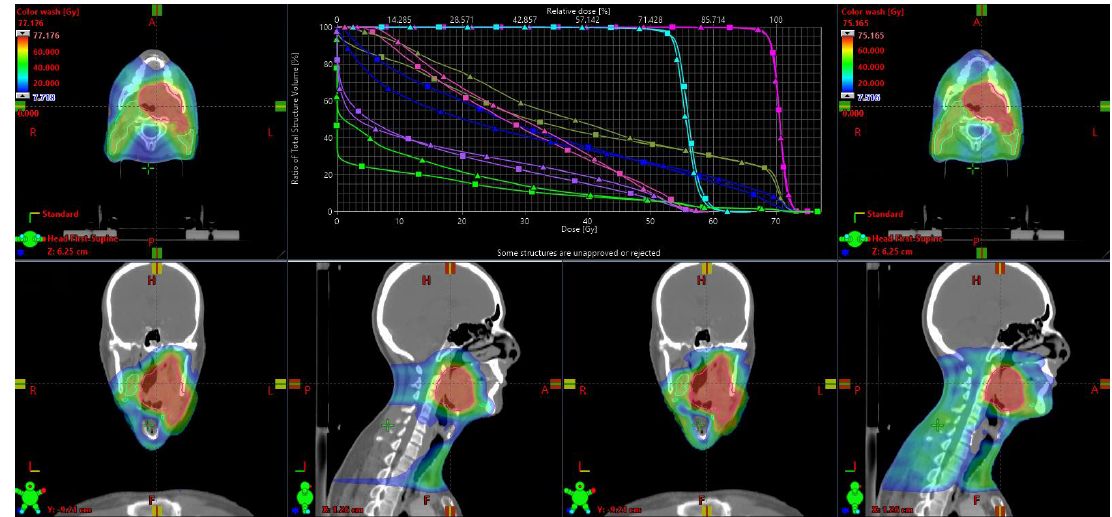
Figure 1. Comparison of dose distribution and dose volume histograms (DVH) for IMPT (left, squares) and TB (right, triangles) plan. Bright pink = boost planning target volume (PTVB), light blue = elective planning target volume (PTVE), green = body, purple = contralateral parotid, blue = upper larynx, pink = contralateral submandibular gland, moss green = oral cavity.